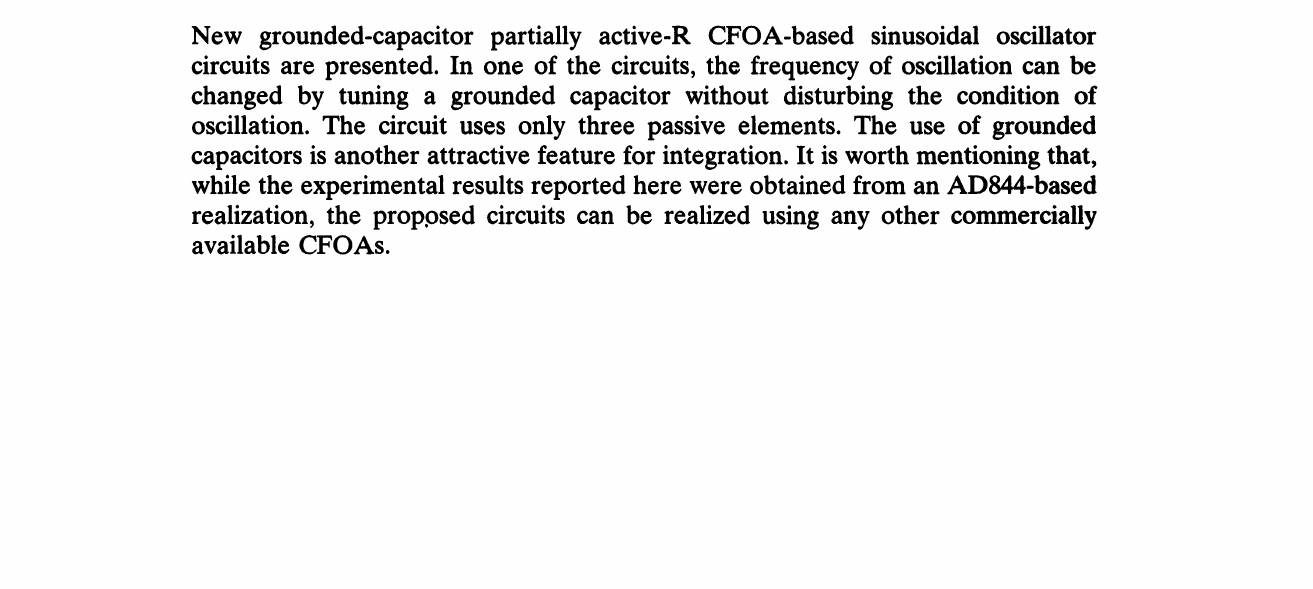
FIGURE 2 Simplified equivalent Circuit for the CFOA